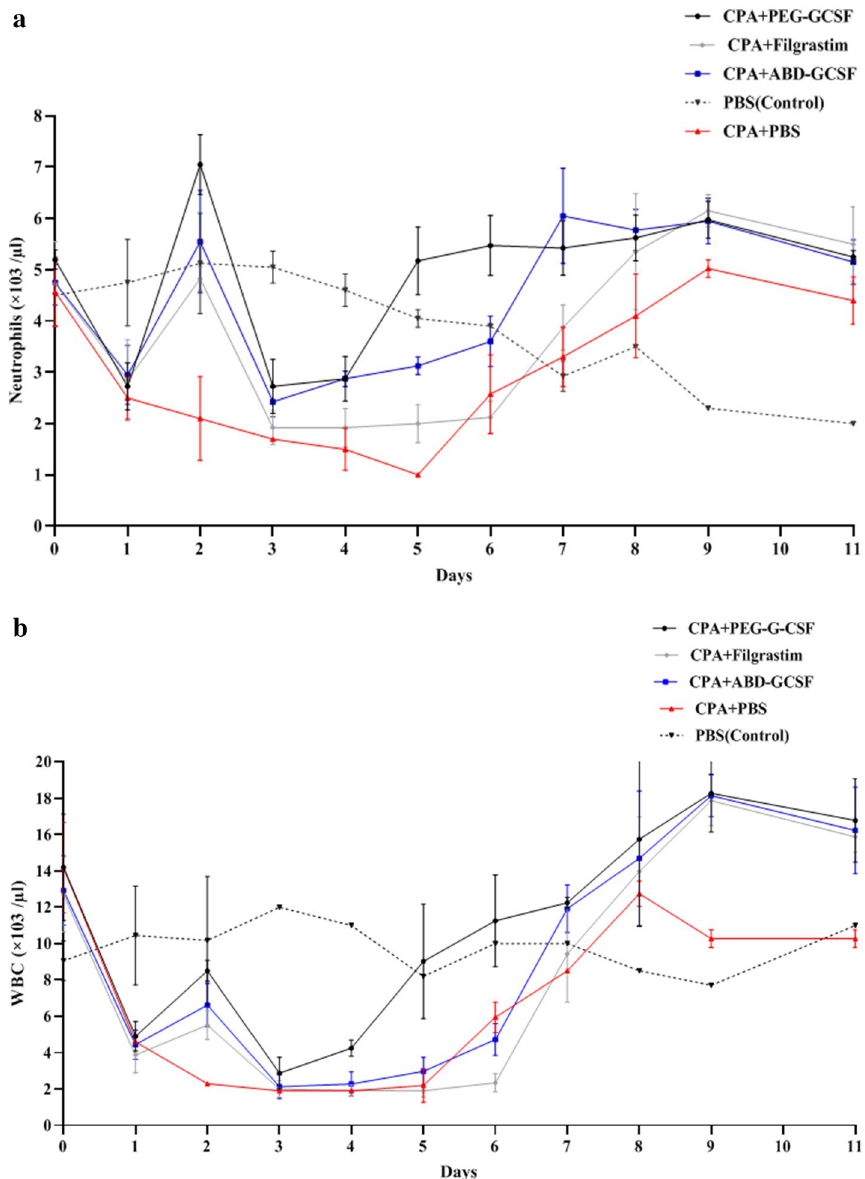
Figure 9. Mean of (a) neutrophil and (b) WBC counts in neutropenic rats after receiving single doses of GCSF derivatives. Data are means ± SE of 3 random rats/group.